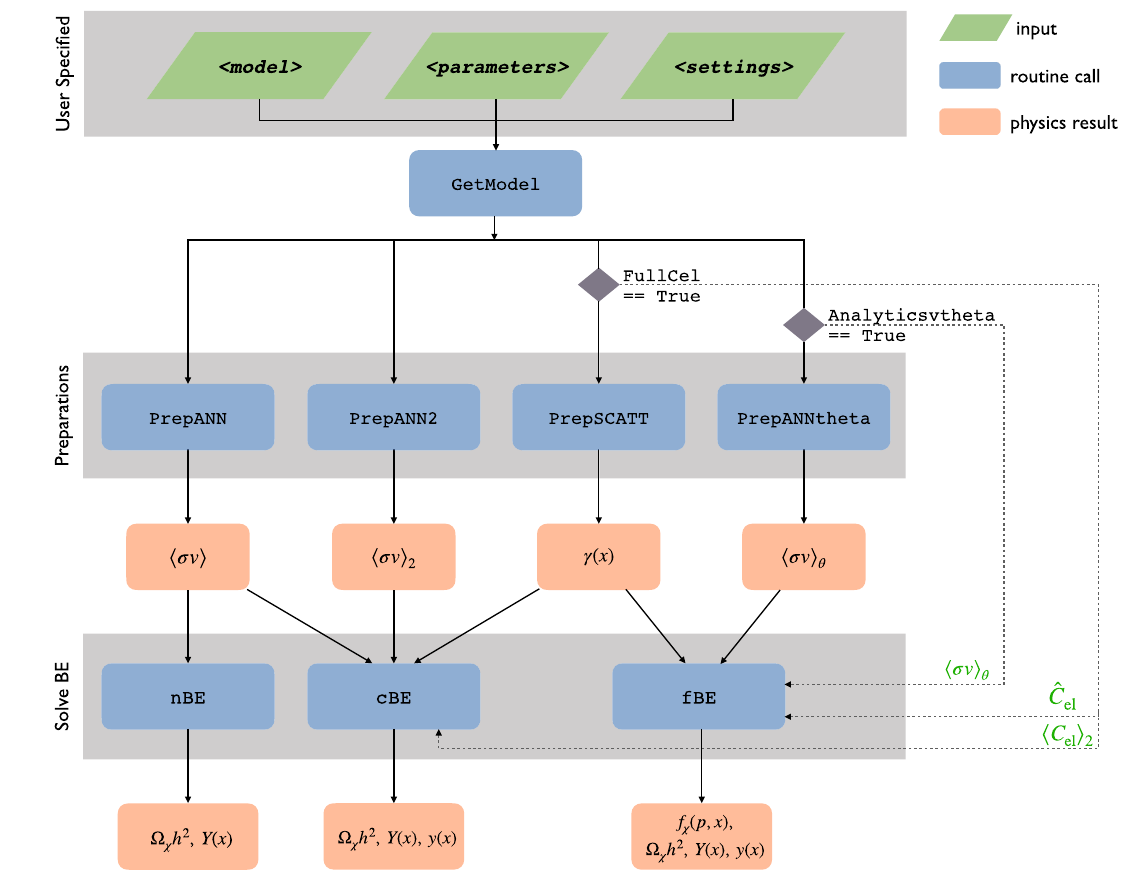
(cid:8) C (cid:9) (cid:8) σv (cid:9) θ or, respectively, ˆ C el and el 2 , need to be provided by (any of) the user defined < files > (as indicated by the green texts along the dashed lines). The main physics output of each preparatory routine is stated in the respective red box right below, and the subsequent calls of the Boltzmann equation solvers nBE , cBE and fBE depend on these physical quantities as indicated by their incoming arrows. The output from each Boltzmann solver, finally, is explicitly stated in the red boxes in the bottom